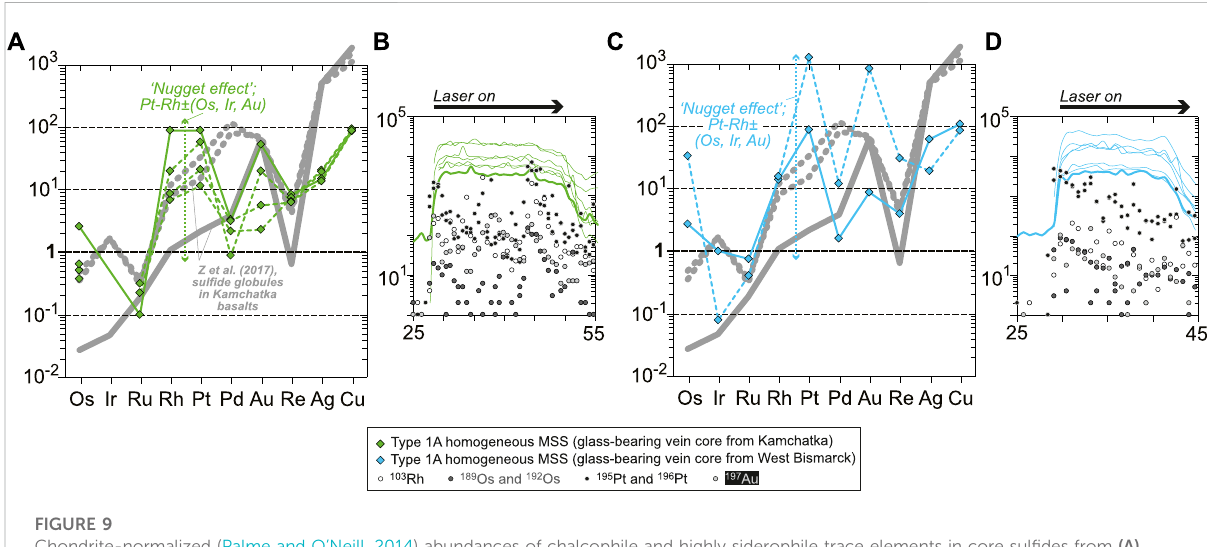
FIGURE 9 Chondrite-normalized (Palme and O ’ Neill, 2014) abundances of chalcophile and highly siderophile trace elements in core sul fi des from (A) Kamchatka and (D) West Bismarck Type 1A veins. Representative laser ablation signals for (B) Kamchatka and (D) West Bismarck sul fi des (corresponding to solid patterns in chondrite-normalized plots) are also shown. All these sul fi des display signi fi cant spikes in their laser ablation signals,resultingfromthepresenceofPtalloys( “ nuggeteffect ” ).NotethatPtspikesarecombinedwiththoseofRh,andtovaryingextents,Os,Ir and Au in (A) and (C) . Literature data included for comparison in (A) and (C) are chondrite-normalized patterns of “ nugget-free ” (solid gray patterns) and “ nugget-bearing ” (dotted gray patterns) sul fi de globules from Tolbachik volcano lavas (high-Mg basalts) in Kamchatka (Zelenski et al.,